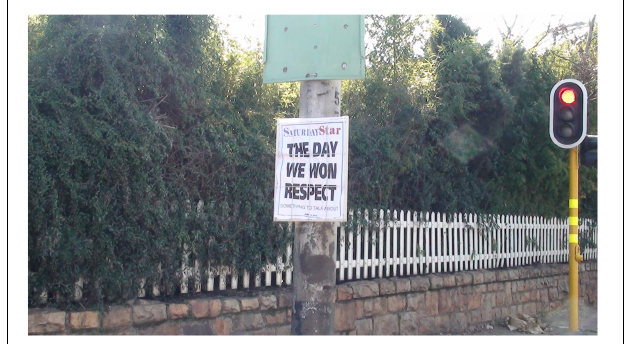
FIGURE 9 | Advertising reflecting expectations of Bafana Bafana as a source of national pride.